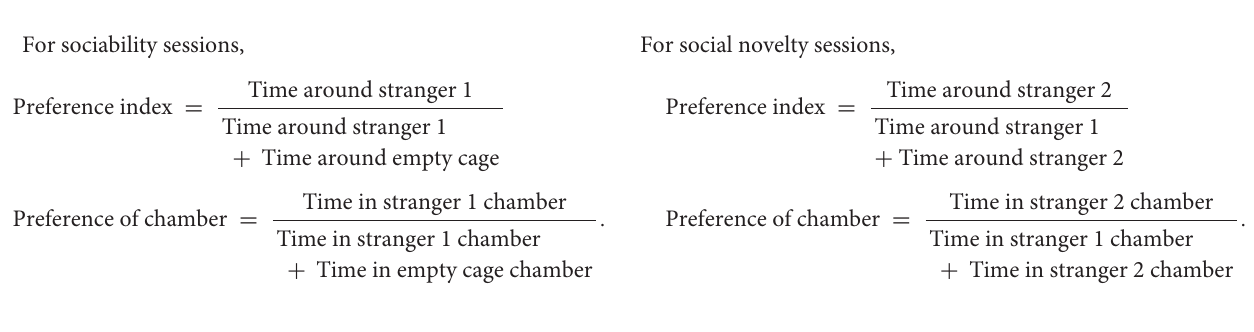
FIGURE 2 | Experimental design of this study. (A) Diagram of experimental procedures. The duration of vapor exposure is 30 min per day and 7 days a week. Veh cont, Vehicle control of propylene glycol/vegetable glycerin; Nico, Nicotine; Nico + ment, nicotine with menthol flavor. (B) Schematic workflow of this study. Veh cont, Vehicle control of 50% propylene glycol (PG) + 50% of vegetable glycerin (VG); Nico: 4% of Nicotine + 46% of PG + 50% of VG; Nico + ment: 10% of menthol flavoring agent + 4% of Nicotine + 35% of PG + 51% of VG.